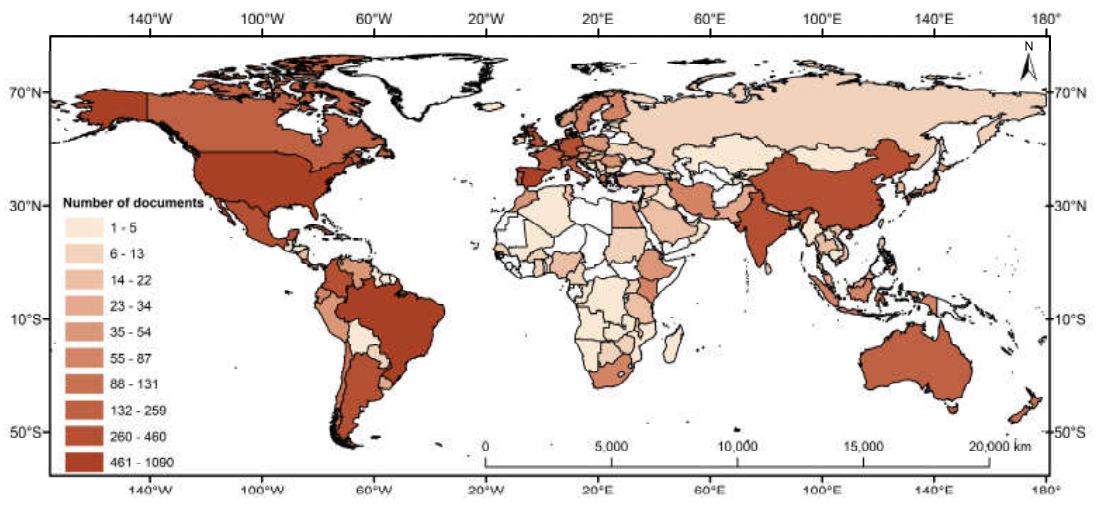
Figure 4. Number of publications on silvopastoral systems by country.